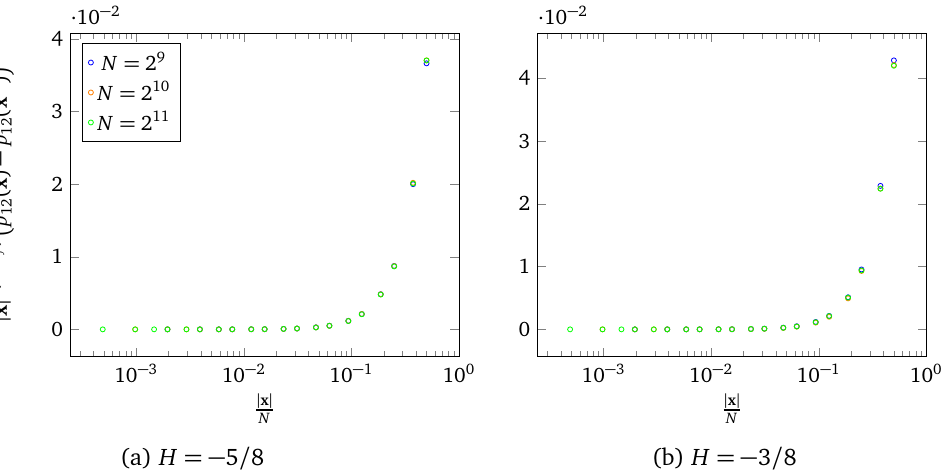
Figure 8: Convergence of the data points for the difference of connectivities (28) on rectangular torus M = 2 N , for H = − 5 / 8 (a) and H = − 3 / 8